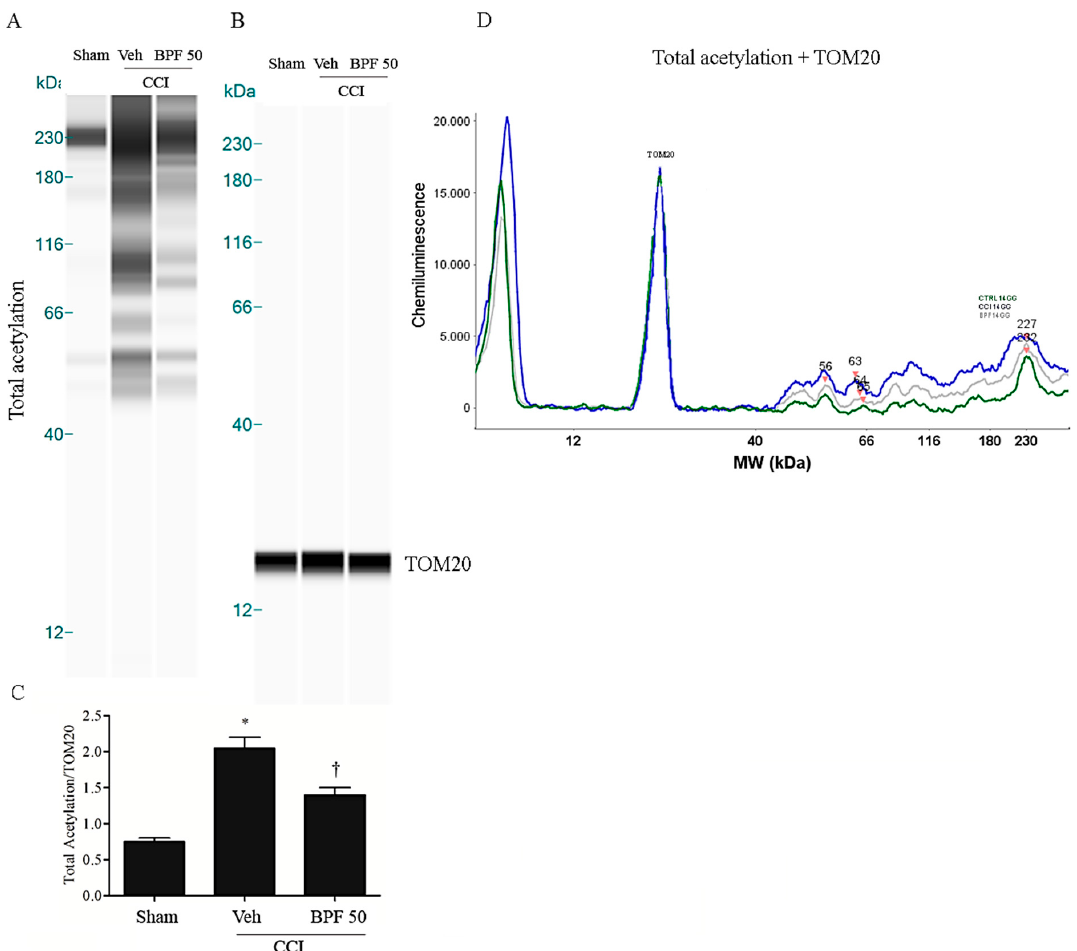
Figure 8. The inhibition of SIRT3 induces acetylation on mitochondrial proteins 14 days post injury. ( A ) Inactivation of SIRT3 led to significant acetylation of mitochondrial proteins 14 days post injury as shown by WES methodology. Subcutaneous infusion of BPF (50 mg/kg), concurrently with surgery (day 0), prevented mitochondrial proteins acetylation. ( B ) No difference for TOM20 expression was detected among the lanes in these conditions. ( A , B ) Lanes and ( D ) electropherogram are representative of results from 6 animals. ( C ) Densitometric analyses of all animals per groups are reported. Results are expressed as mean ± SEM for 6 rats. * p < 0.05 versus sham; † p < 0.05 versus vehicle +